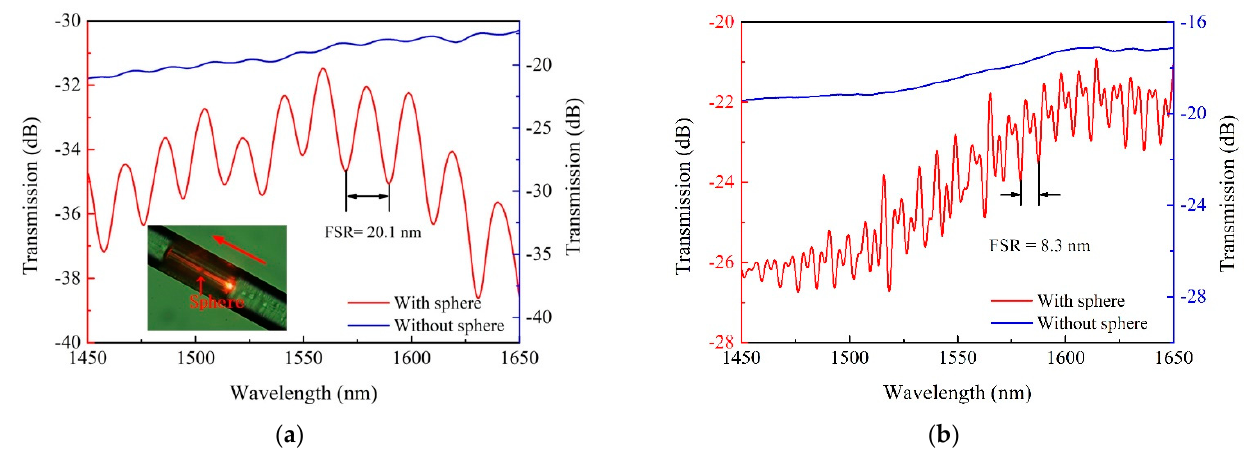
Figure 3. Detected transmission spectra before and after mounting a microsphere with a diameter of ( a ) 20 μ m and ( b ) 50 μ m.